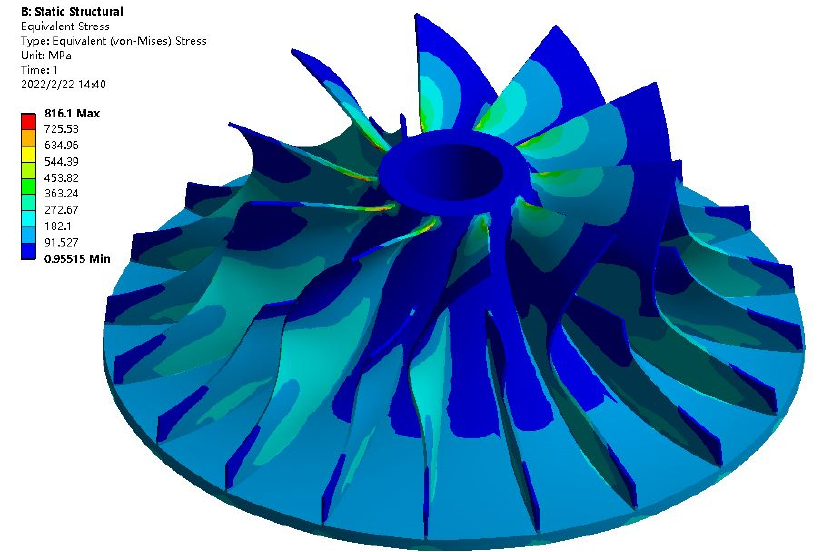
Figure 10. Equivalent stress distribution of Type O.